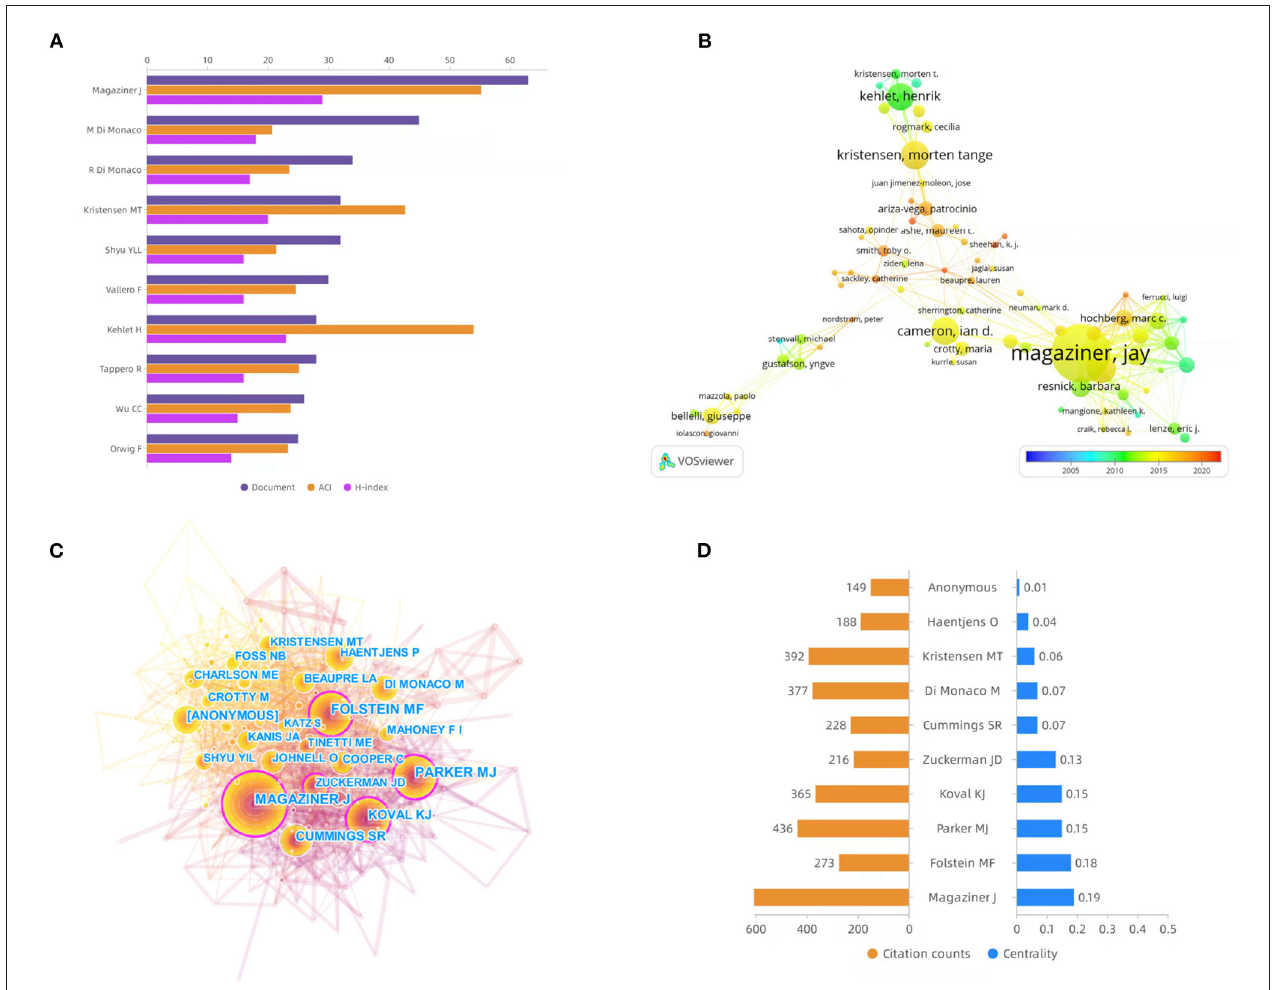
FIGURE 5 | (A) The publication counts, H-index, and ACI of the top 10 most prolific authors. (B) Overlay visualization map of author coauthorship analysis generated by VOSviewer software. (C) Visualization map of author co-citation analysis by using CiteSpace software. (D) The citation counts and centrality of the top 10 most co-cited